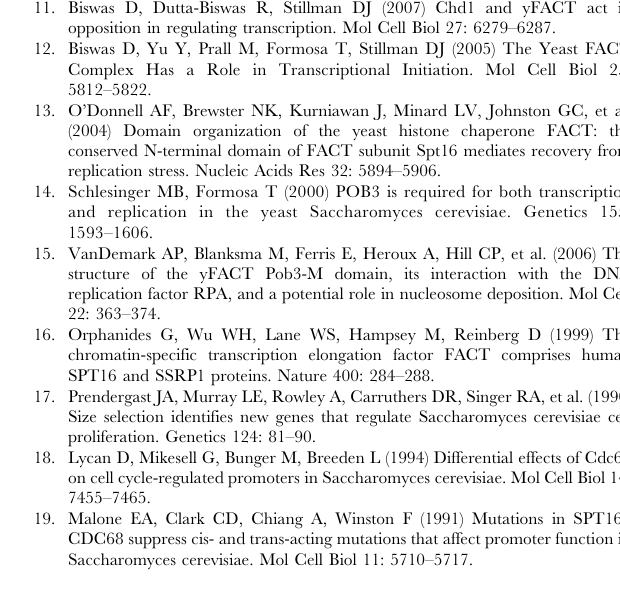
presence of the mating pheromone. Cells were then released from the arrest at time 0 at either 25 u C or 35 u C by washing out the alpha-factor. Samples were taken at the indicated time points to analyze mRNA levels by Northern blot. H2A indicate the signal corresponding to HTA1 and HTA2 , and H3 indicate the signal of HHT1 and HHT2 . PDF) Figure S6 hhf1-36 and rad53K227A exhibit a negative synthetic interaction. Strains MSY623, DMY15, MSY781, and DMY16 exponentially grown in YPD at 30 u C were spotted onto YPD plates and incubated for three days at 30 u C and 37 u C, as indicated. Found at: doi:10.1371/journal.pgen.1000964.s006 (0.16 MB PDF) Table S1 The yeast strains used in this work. Found at: doi:10.1371/journal.pgen.1000964.s007 (0.03 MB DOC) Text S1 Supplementary material and methods and supplemen- tary